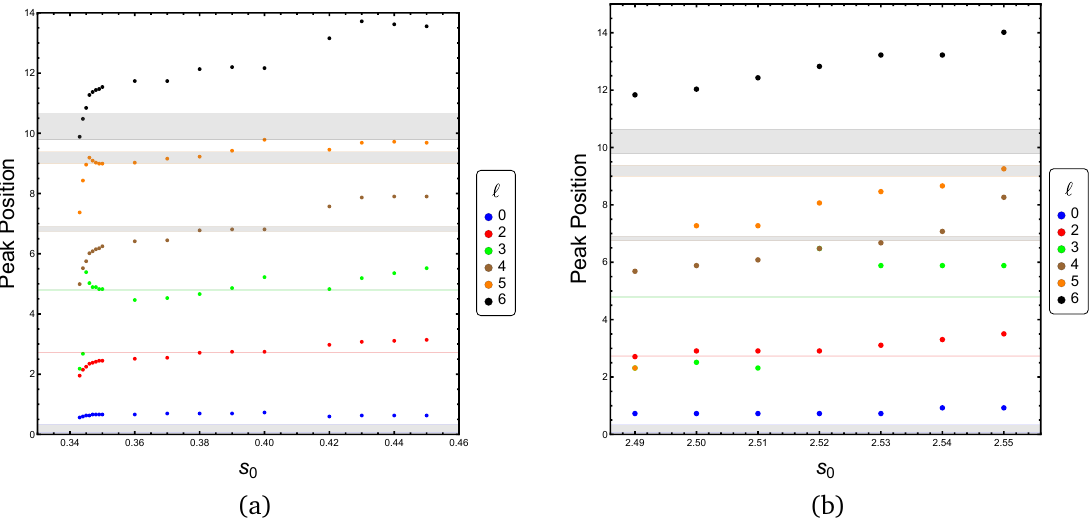
Figure 10: (a) Position of peaks vs s 0 near the kink A and (b) Position of peaks vs s 0 near the kink C . These peaks were calculated for N max = 16 and L max = 19. The bands of a particular color indicate the experimental range of resonances associated with that spin. Uncertainties taken from [ 29 ] and re-scaled in units of ρ